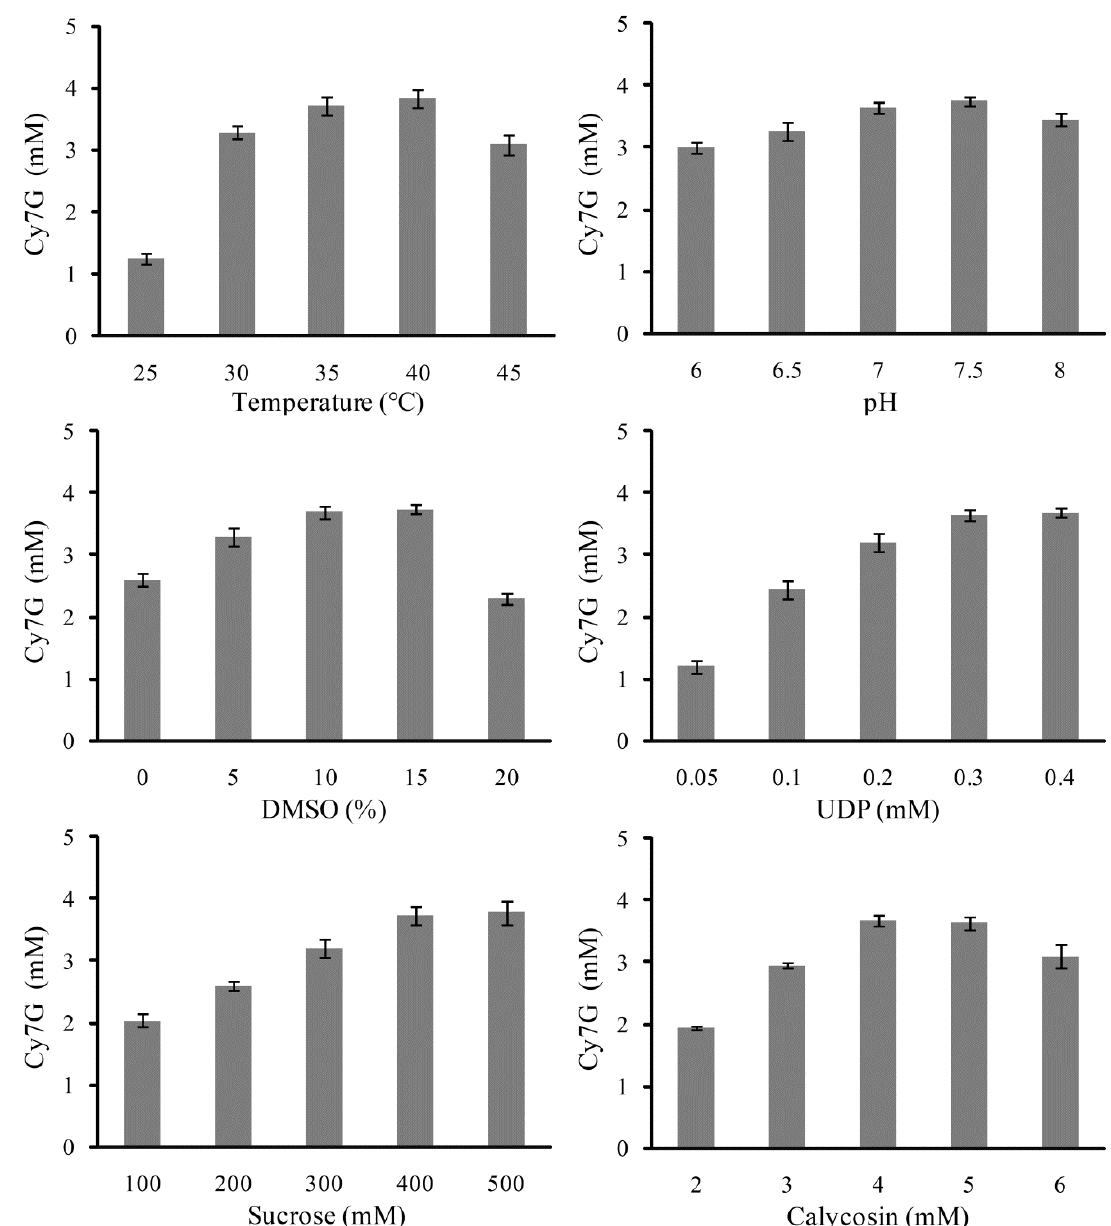
Figure 3. Optimization of reaction conditions for UGT88E18 – SuSy cascade reactions.